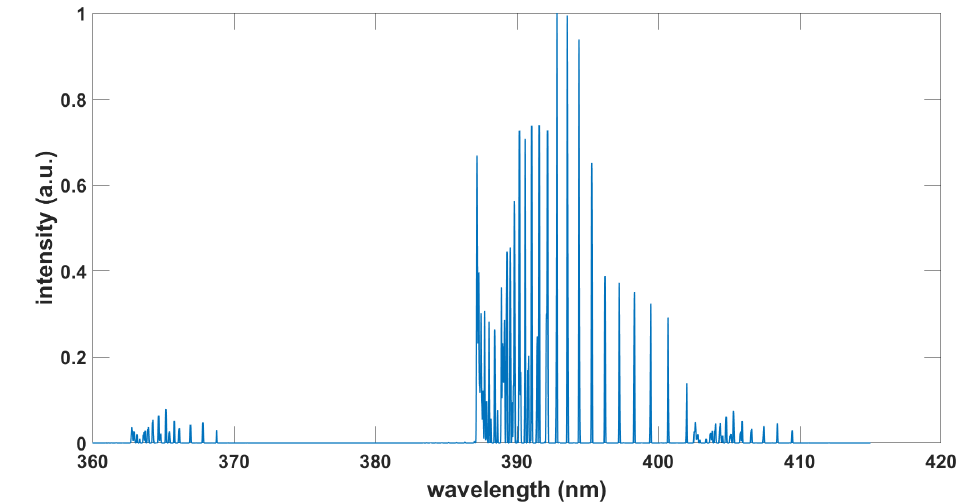
Figure 2. Computed CH B − X spectrum, ∆ v = 0, + 1, δ λ = 0.05nm, T = 3.0